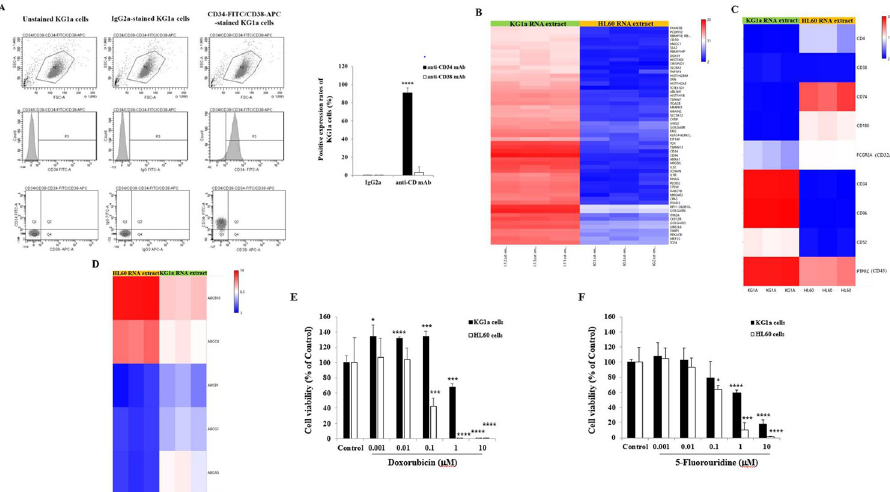
Fig 1. Characterization of the chemoresistance potential of leukemic stem-like AML cell line KG1a. (A) Representative cell scatter plots and histogram analysis of leukemic stem-like AML cell line KG1a after immuno-cyto- staining with FITC-labeled anti-CD34 antibody, with APC-labeled anti-CD38 antibody or with respective IgG2a-FITC and IgG2a-APC isotype controls confirming the phenotypic characteristic of the chemoresistance potential of stem cells defined as CD34 + /CD38 - . Bar graph showing the positive expression rates of KG1a cells based on CD34 and CD38 cell surface detection. (B) Transcriptomic profiling and analysis of differentially expressed genes in AML KG1a stem cells and HL60 cells. Using the Clariom ™ D Human Transcriptomic array, selection of the top 100 differentially expressed genes. (C) KG1a and HL60 cell characterization based on selected transcriptomic profiling using the ClariomD ™ array. (D) Highlight on the top differentially expressed drug resistance-related genes in HL60 and KG1a cells. (E, F) Bar graphs showing the percentage viability of the KG1a and HL60 cells treated with various concentrations (0.001–10 μ M) of either Doxorubicin (D) or 5-Fluorouridine (E). After 72 h incubation, the cell viability was determined using CellTiter-Glo 1 and expressed as percentage of the control, the non-treated cell viability, corresponding to 100%. The results are presented as mean ± SD and were repeated through three independent experiments. � p < 0.05, ��� p < 0.001, and ���� p < 0.0001 vs . control.